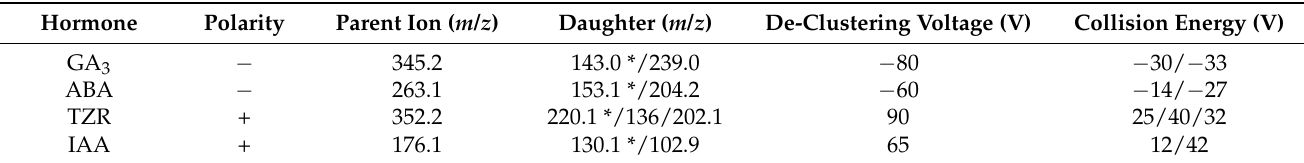
Table 4. Selected reaction monitoring conditions for protonated or deprotonated plant hormones ([M+H]+ or